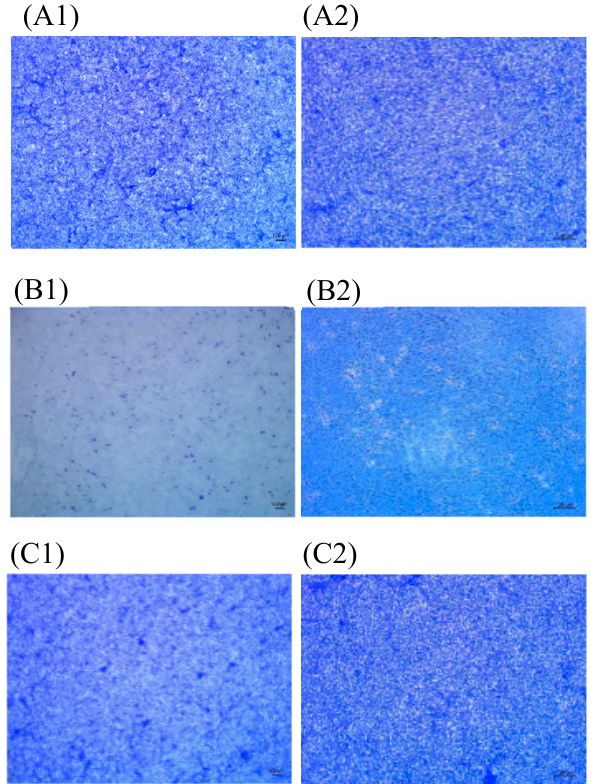
Figure 2. Microscopy image of vero monolayers. Vero cells were inoculated with salivary swab. (A) Vero cell cultures in negative control. 40× ( A1 ), 100× ( A2 ) micrograph. (B) Vero cell cultures in positive control. 40× ( B1 ), 100× ( B2 ) micrograph. (C) Microscopy image of Vero cells inoculated with salivary swab sample of a patient 33 days after diagnosis. No cytopathic effect was seen. 40× ( C1 ), 100× ( C2 ) micrograph. Virus stock used for positive control was obtained from the Centers for Disease Control and Prevention (KCDC), the virus titer was 2.2 × 10 5 PFU/mL and the Ct value was 11. (KCDC03 43326).